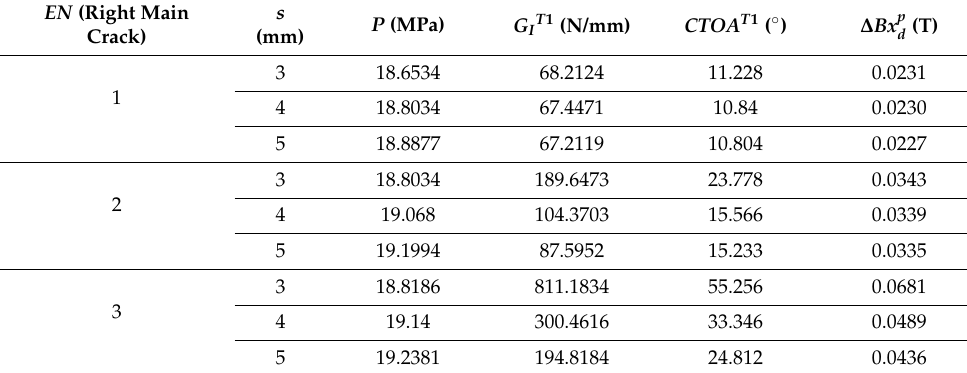
Figure 9. Crack propagation model under the certain load step. ( a ) P = 18.8186 MPa s = 3 mm, ( b ) P = 19.14 MPa s = 4 mm, ( c ) P = 19.2381 MPa s = 5 mm. Table 5. Interference effect of crack tip distance on main crack.